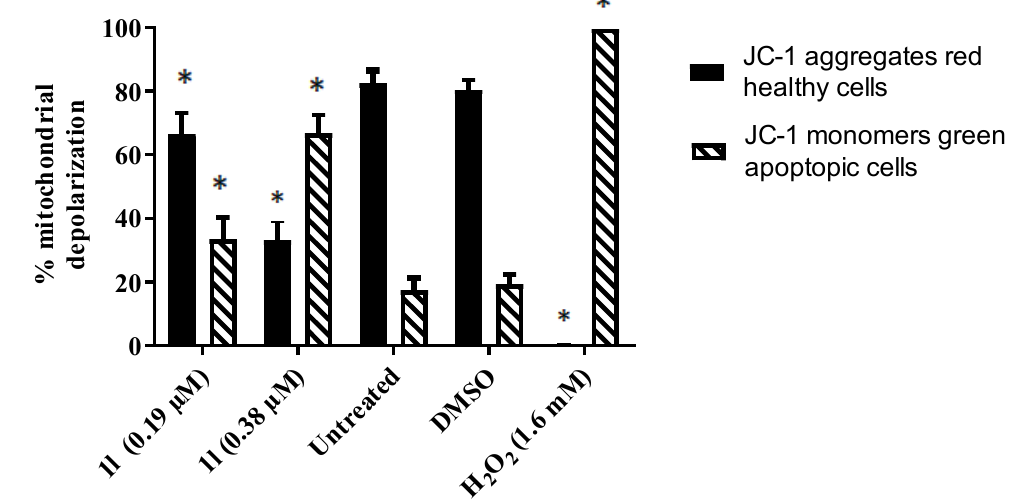
Figure 3. Evaluation of 1l on the mitochondrial membrane potential of Ramos cells. The asterisks indicate a statistically significant difference ( p < 0.05) from solvent-treated (DMSO) cells.